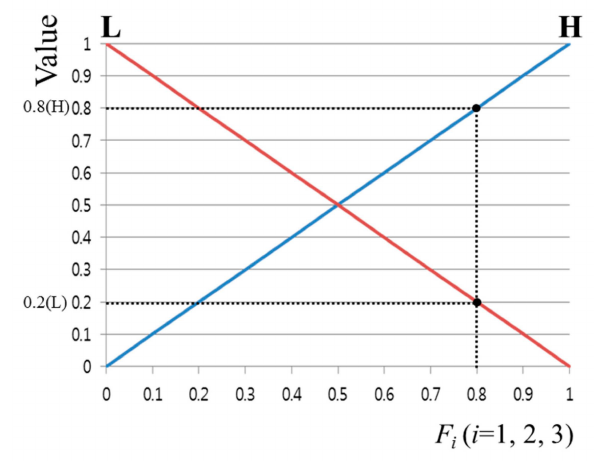
Figure 9. Example of obtaining an output value when one input value is input into the input membership function.